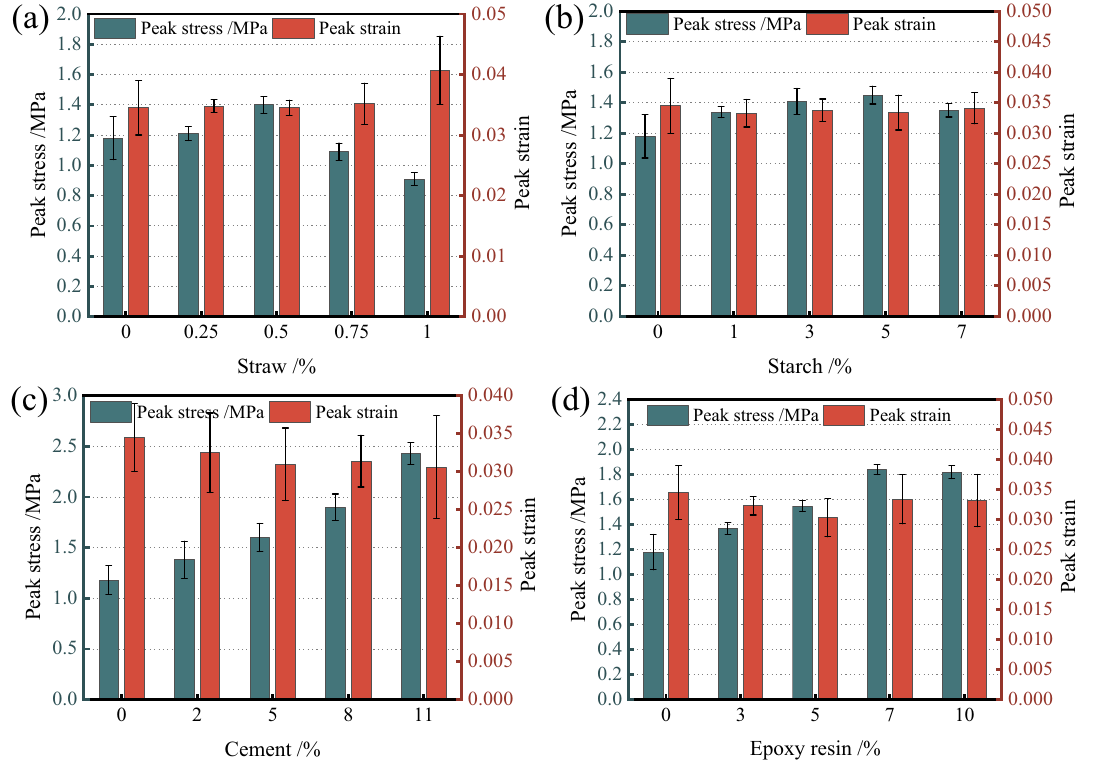
Figure 7: Peak stress and strain of test block. ( a ) straw; ( b ) starch; ( c ) cement; and ( d ) epoxy